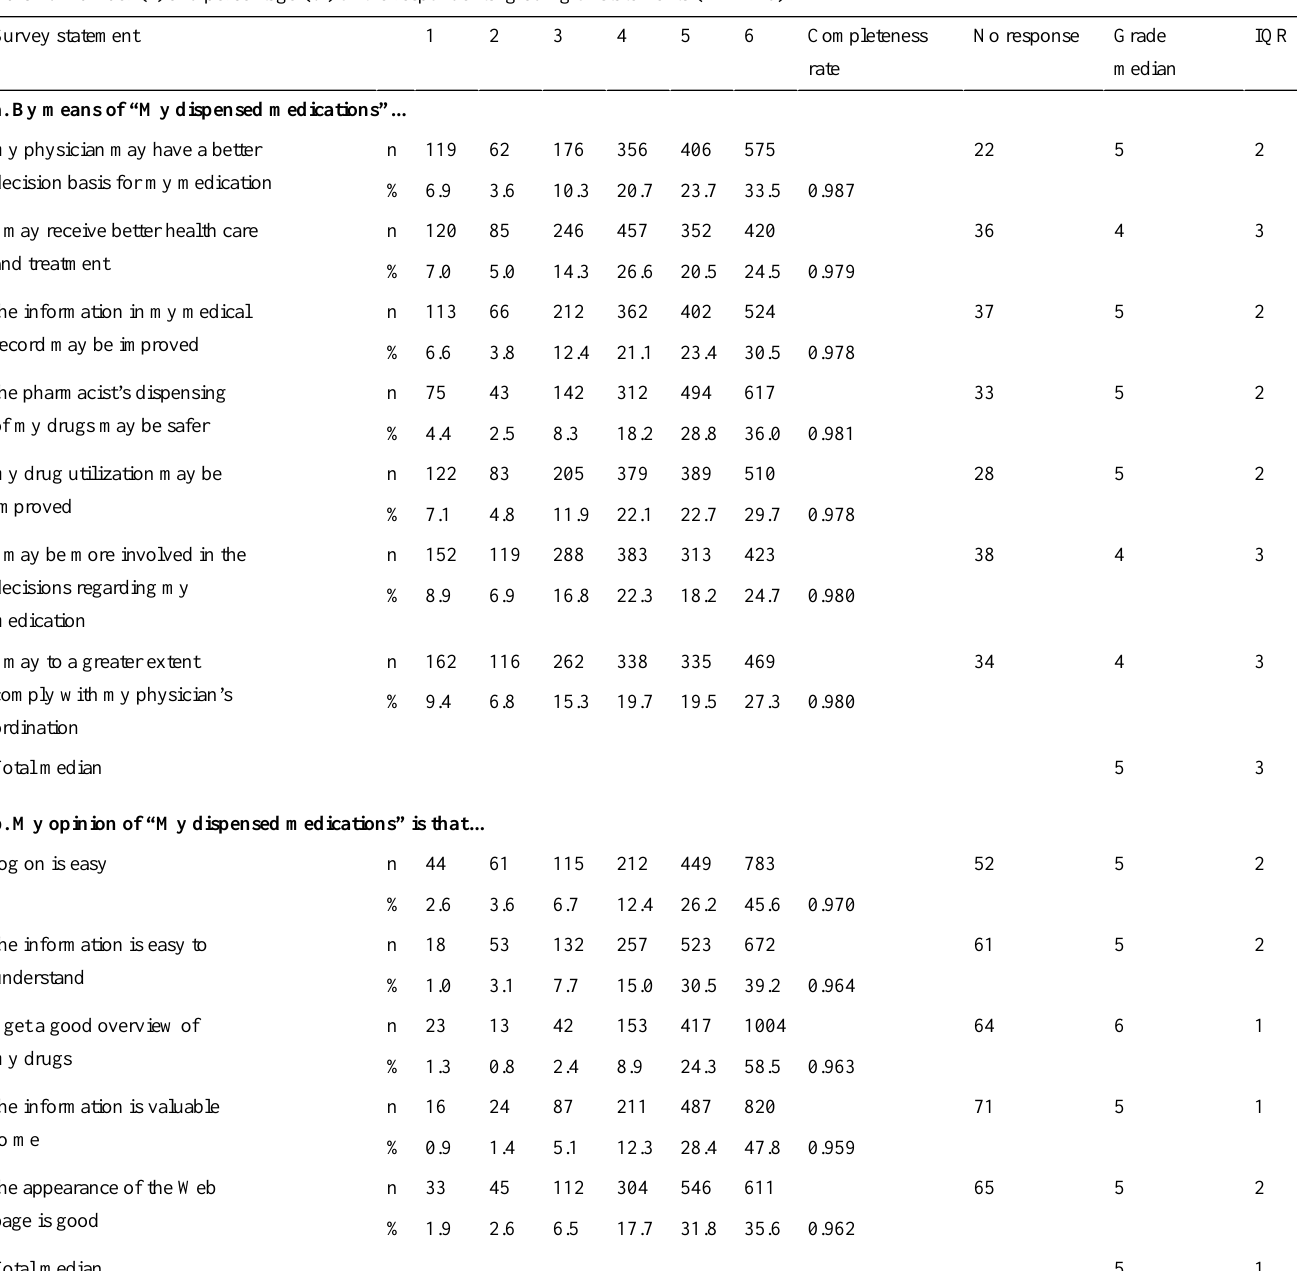
Table 1. Number (n) and percentage (%) of the respondents’grading of statements (n = 1716) *